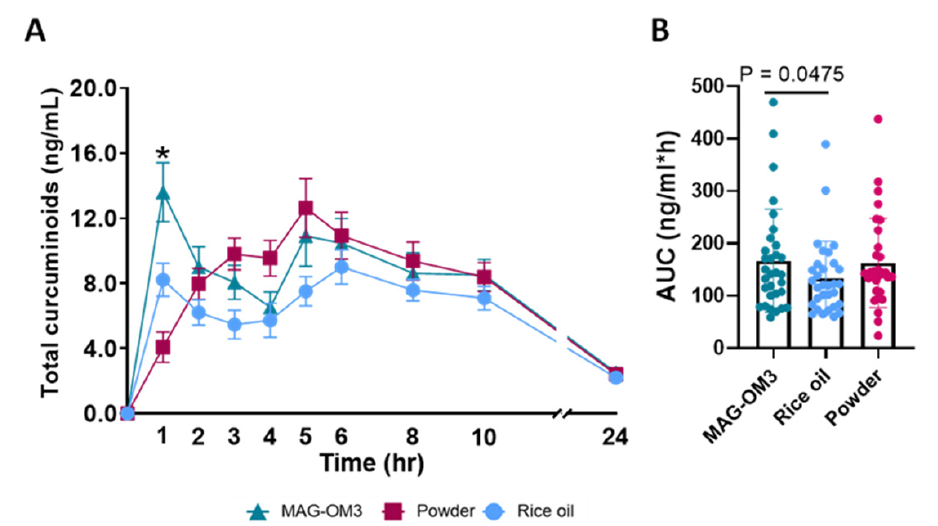
Figure 3. ( A ) Pharmacokinetic over 24 h of total plasma curcuminoids (ng/mL) after providing a single dose intake of curcuminoids combined with monoglycerides omega-3 fatty acids (MAG- OM3), rice oil or alone in powder. The data are expressed means ± SEM and are delta over the baseline. A repeated measure two-way ANOVA was performed to compare the different formula- tions and a Turkey’s multiple comparisons test was performed when the ANOVA was significant to determined which group different from the other. * Represent p < 0.05. ( B ) Area under the curve of total curcuminoids for each formulation (ng/mL*h). Data were compared using a Friedman non- parametric test followed by Dunn’s multiple comparison test when require.